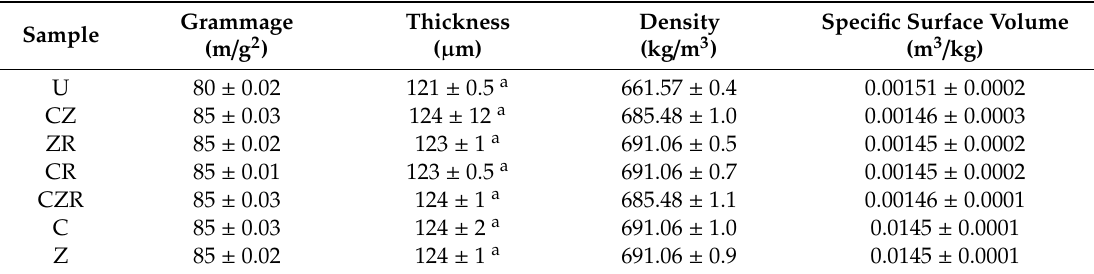
Table 1. Determination of the basic properties of uncoated (U), chitosan and zein coated (CZ), blend zein and rosemary oil coated (ZR), blend chitosan and rosemary oil coated (CR), chitosan and blend zein and rosemary oil coated (CZR), pure chitosan in one layer coated (C) and the pure zein in one layer coated (Z) paper